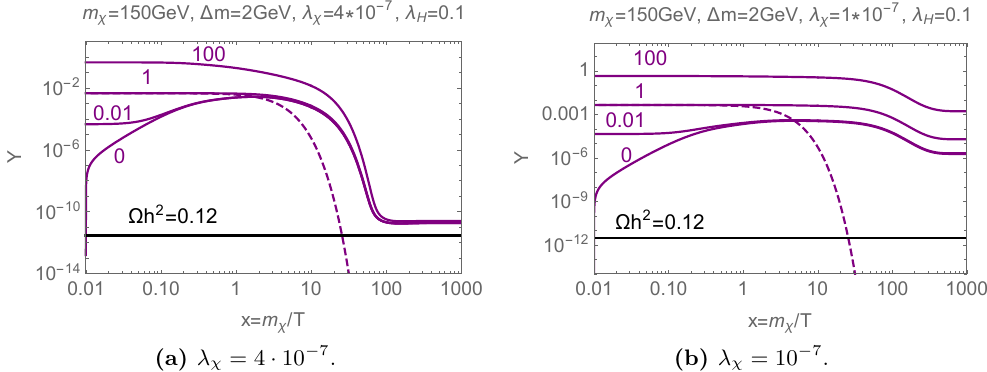
Figure 9 . Plotting the evolution of the yield for di(cid:11)erent initial conditions: Y (cid:31) [1] = i (cid:1) Y (cid:31); with i 2 f 0 ; 0 : 01 ; 1 ; 100 g . Both (cid:12)gures are calculated with for the parameters m (cid:31) = 150 GeV and (cid:1) m = 2 GeV but for two di(cid:11)erent values of the coupling, (cid:21) (cid:31) = 4 (cid:1) 10 (cid:0) 7 (left) and (cid:21) (cid:31) = 10 (cid:0) 7 (right). The dashed lines denote the equilibrium yield. sake of illustration we also show how the (cid:10) h 2 curve is a(cid:11)ected varying m in (cid:12)gure 8, see also the discussion in section